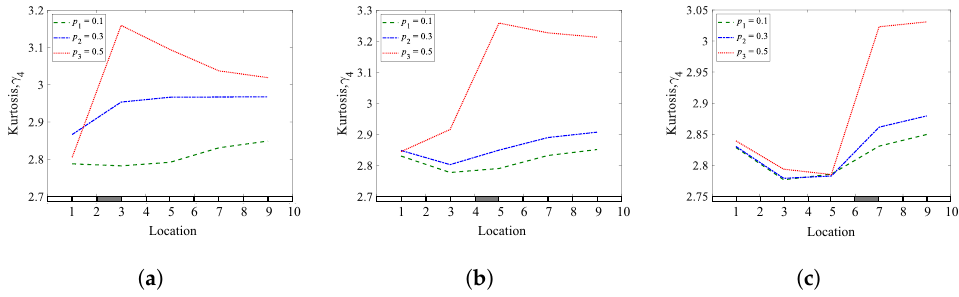
Figure 24. The effect of reducing the number of measurement points (5 points) on damage local- ization using kurtosis coefficients at various crack depths and locations: ( a ) q 1 = 0.25; ( b ) q 2 = 0.45; ( c ) q 3 = 0.65.